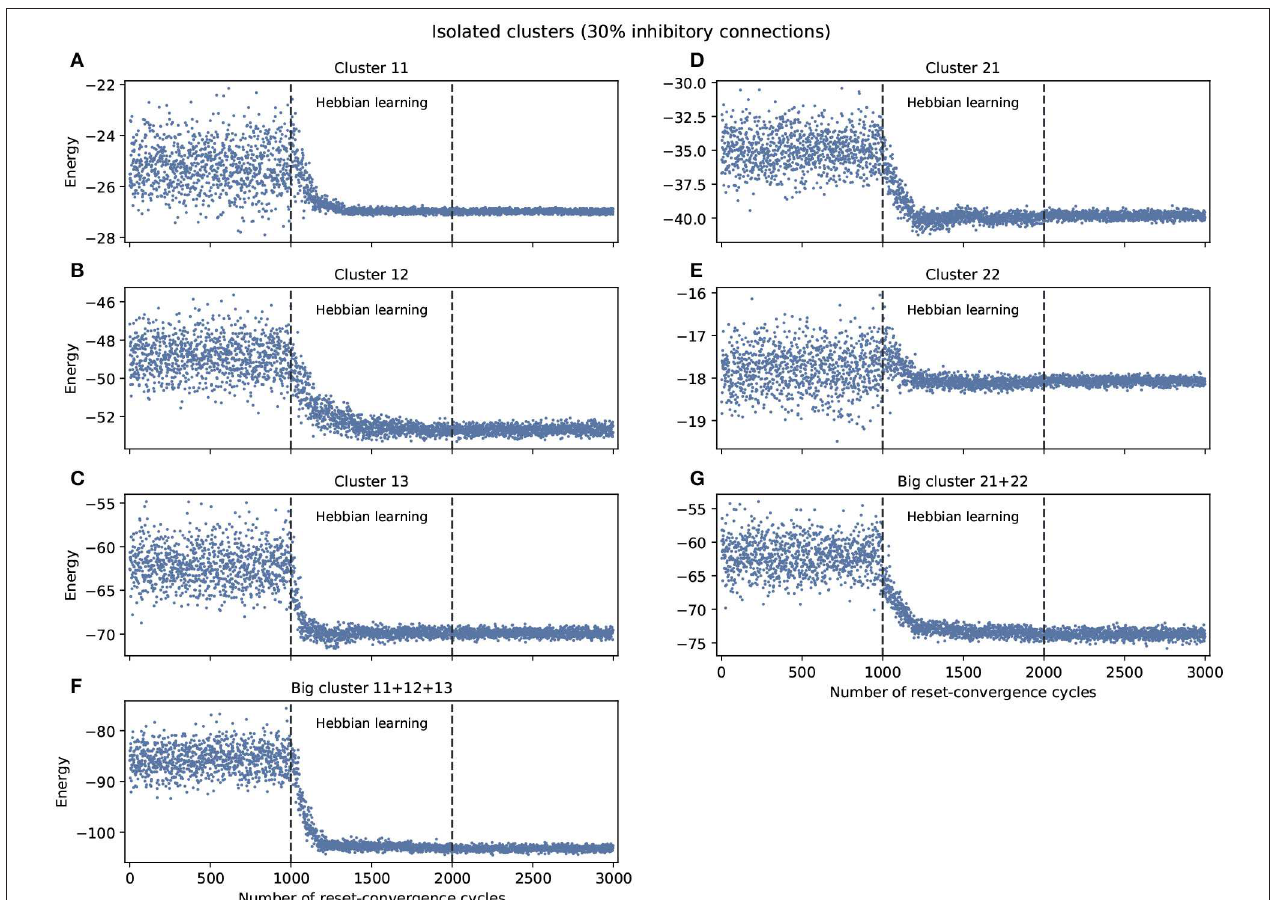
FIGURE 1 | Examples of self-optimization in different C. elegans clusters with 30% inhibitory connections; each panel was run separately (independent to the rest of the connectome). The learning rate in each experiment was proportional (regarding the edges) to the one used with the entire connectome and proved to be suitable in the previous work of Morales and Froese (2019). (A–E) Correspond to the clusters 11, 12, 13, 21, 22, respectively. (F,G) Belong to the two big clusters formed at a higher level from the previous: the chemosensory cluster (11 + 12 + 13) and the mechanosensory one (21 + 22). Each panel was averaged from 10 different experiments and shows the energy of the neuron states in three distinct phases: before learning (1–1,000), during the self-optimization process (1,001–2,000), and after learning (2,001–3,000). Self-optimization can be observed in almost all panels, but tend to remain a diversity of attractors. The difference in y-scale of each panel underline the complexity of the problem to be solved by self-optimization. Energy values averaged in (A) before self-optimization produce − 25.22 (0.91 SD), during self-optimization − 26.71 (0.61 SD), and after self-optimization − 26.98 (0.06 SD). In the case of (E) we have − 17.78 (0.5 SD), − 18.01 (0.24 SD), and − 18.07 (0.07 SD),